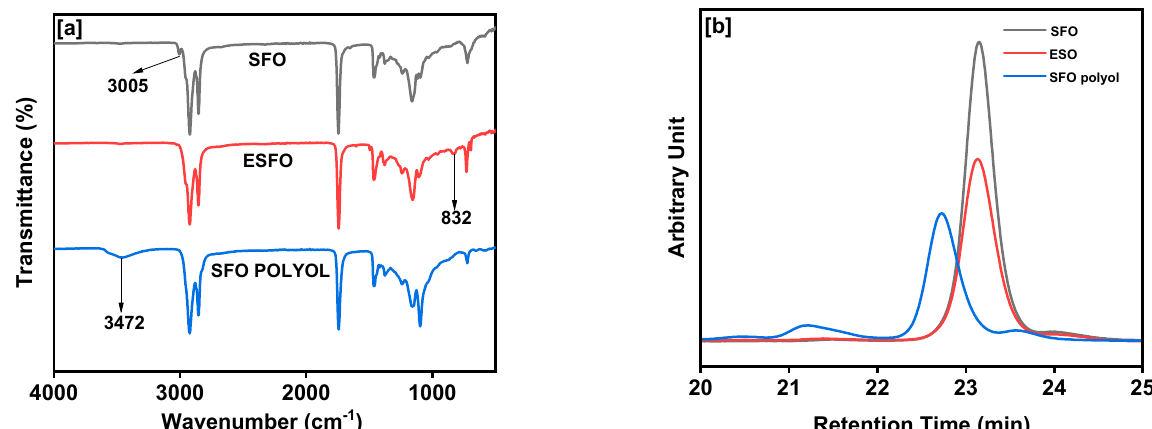
Figure 2. ( a ) FT-IR spectra and ( b ) GPC of SFO, ESFO, and SFO polyol.